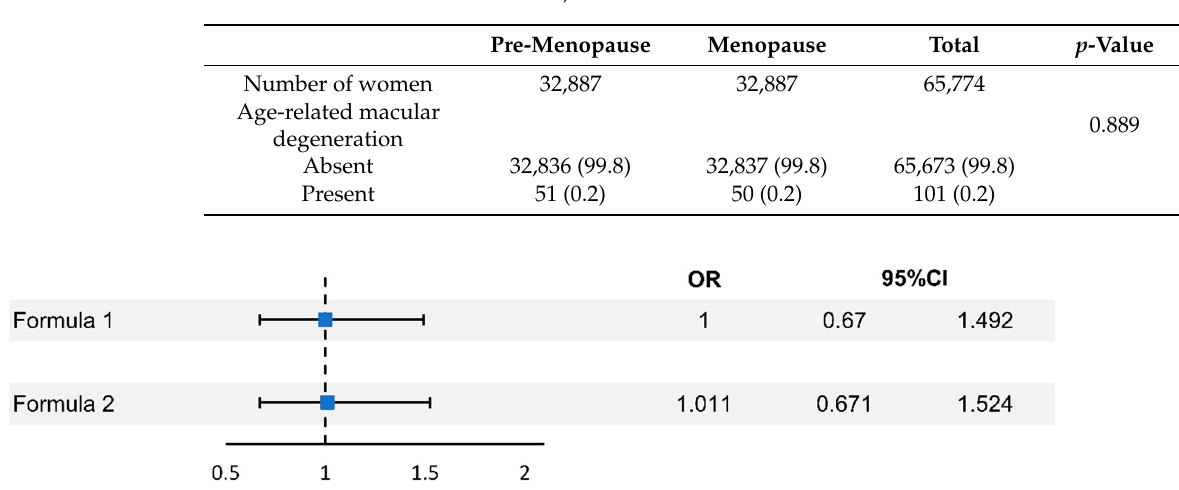
Table 2. The incidence of age-related macular degeneration with/without menopause. Korea National Health Insurance Database, 2007–2020.